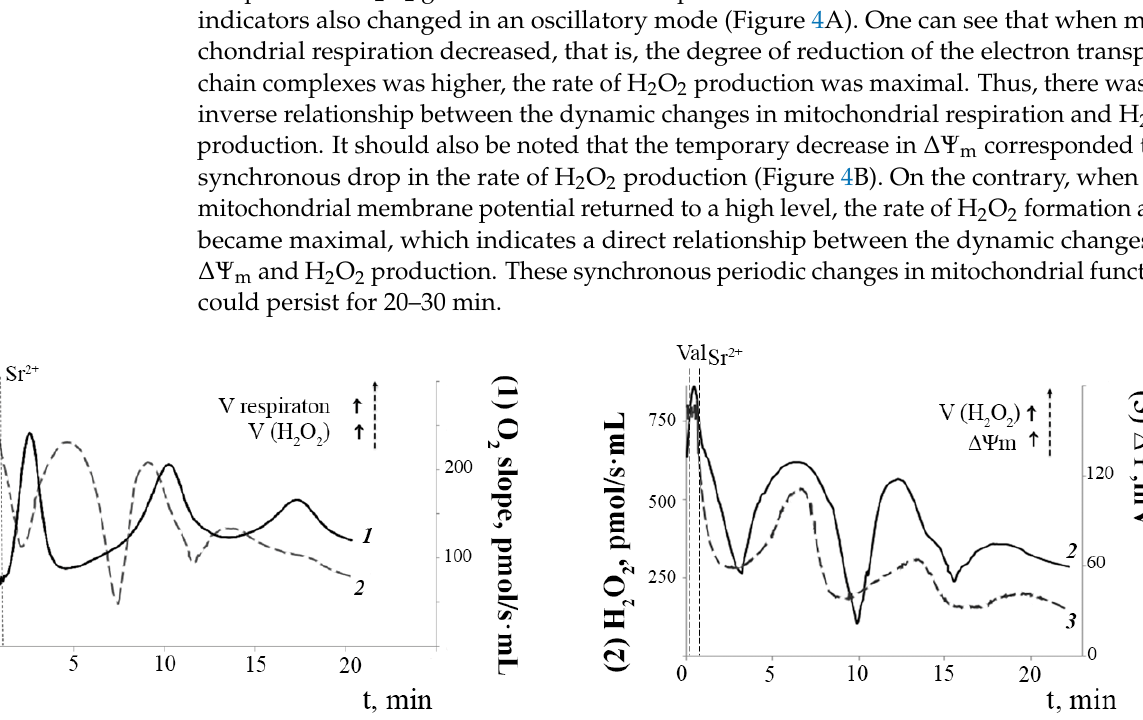
Figure 3. Sr 2+ /valinomycin-induced cyclic changes in matrix volume of rat liver mitochondria. The experimental conditions were the same as in Figure 2. Additions: 2 ng valinomycin and 45 nmol SrCl 2 /mg of protein. The typical traces are presented ( n = 5).